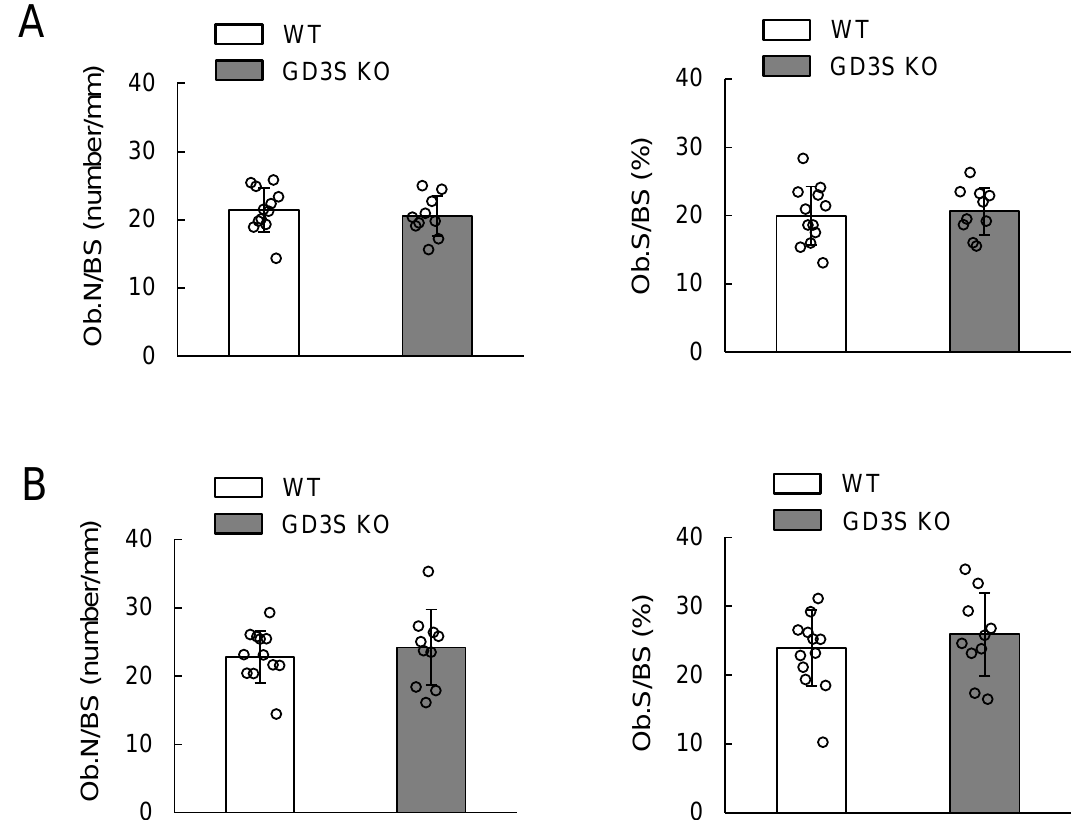
Figure 5. No e ff ects of GD3 synthase deficiency on osteoblast numbers shown in vivo. ( A ) 15-week-old mice (male, n = 12 for WT, n = 10 for GD3S KO). ( B ) 40-week-old mice (male, n = 12 for WT, n = 10 for GD3S KO). Osteoblast numbers / bone surface (Ob.N / BS, number / mm) and osteoblast surface / bone surface (Ob.S / BS, %) are presented. Data are expressed as mean ±